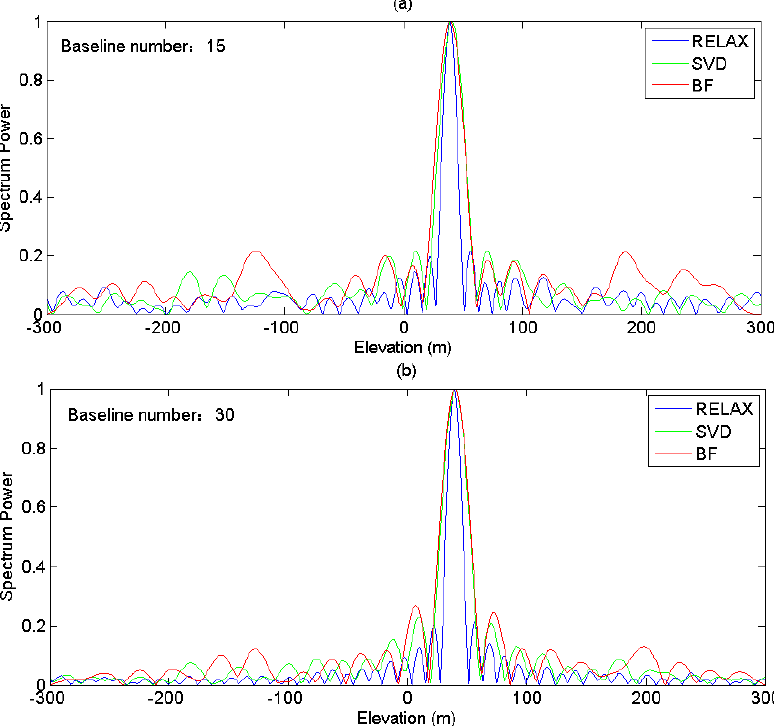
Figure 4. Simulation results of single scatterers under different numbers of baselines. Hs is 40 m; the baseline numbers of ( a ) and ( b ) are 15 and 30, respectively.